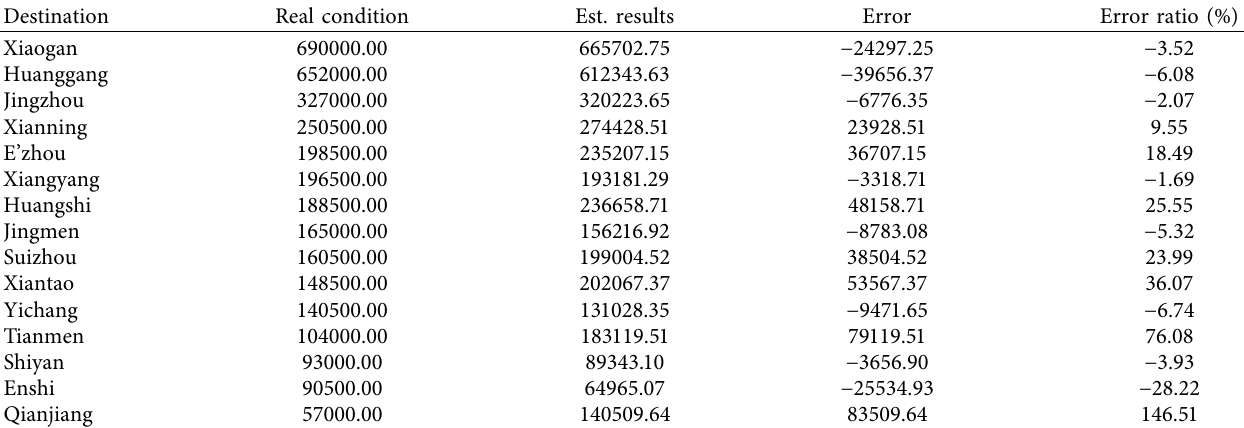
Table 5: Demand distribution estimation and the error of estimation for cities inside the province of Hubei. Destination Real condition Est. results